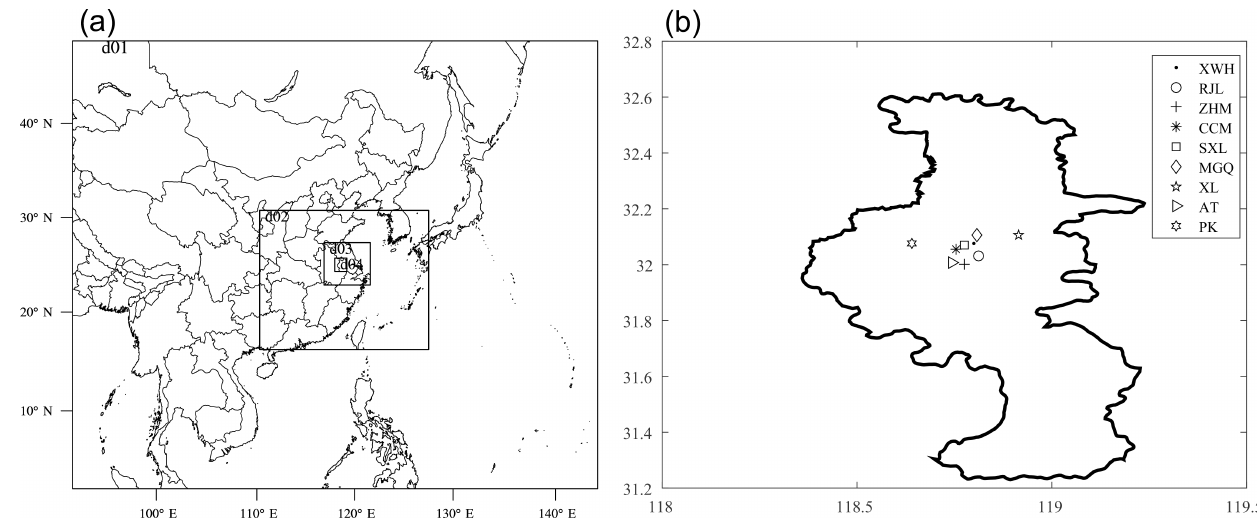
Figure 1. Modelling domains and state-controlled air-monitoring sites in Nanjing. (a) The four nested modelling domains at 81km (d01: eastern Asia), 27km (d02: eastern China), 9km (d03: Yangtze River Delta), and 3km (d04: Nanjing), (b) locations of nine sites in Nanjing.